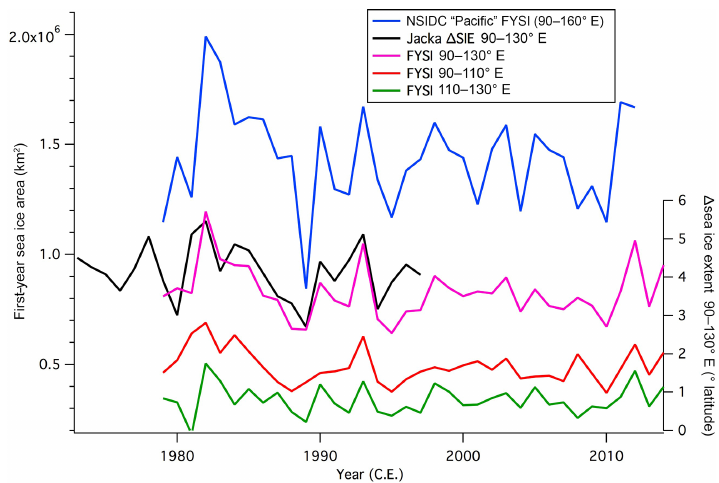
Figure 3. First-year sea ice (FYSI) areas calculated from satellite microwave radiometer observations. The 90–110 ◦ E and 110–130 ◦ E data shown here correspond to the two sectors indicated in Fig. 2. The 90–130 ◦ E FYSI data series (fuchsia) is the sum of the 90–110 ◦ E (red) and 110–130 ◦ E (green) data series. For comparison to previous studies, we include corresponding data series from Jo Jacka (Jacka, 1998) and NSIDC (Fetterer et al., 2002). Note that the NSIDC Pacific sector covers a larger sector (90–160 ◦ E) than the other records shown